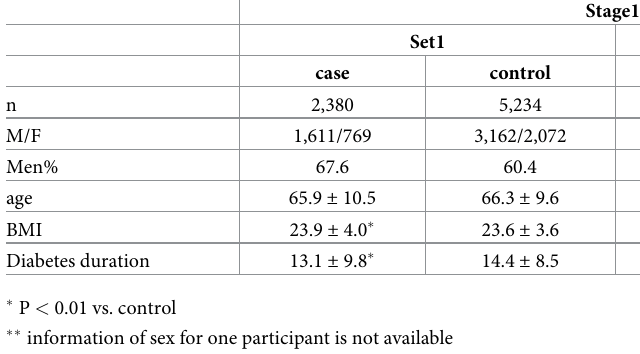
or maturity-onset diabetes of the young were excluded.